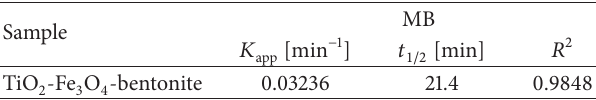
Figure 4: Pseudo-first-order kinetics for the degradation of methy- lene blue. Table 1: Pseudo-first-order kinetic parameters for the photodegra- dation of MB